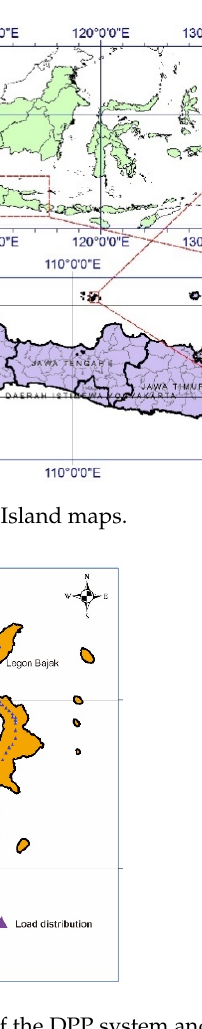
Figure 5. Line diagram of the system proposed with DPP-PV. 3.2. Power System Model and Scenario The Karimunjawa Island electricity system is a stand-alone electricity system without interconnection with Java Island, Central Java. Electricity on the island of Karimunjawa is supplied from the DPP Legon Bajak system. The electrical network diagram of the Legon Bajak DPP system is shown in Figure 5. It appears that the DPP system capacity is 2 × 1.8 MW/20 kV to supply power to Feeder 1 (19.87 kV) and Feeder 2 (19.86 kV). The average load is known to be 0.98 MW, with losses of 1.01%. There is a tendency that the use of electricity is increasing every year on the island of Karimunjawa. In contrast, solar energy in the islands of Karimunjawa has not yet been used as the main power plant, apart from the existing DPP system. Therefore, we propose a hybrid system consisting of a DPP system and a PV system. Thus, the natural potential